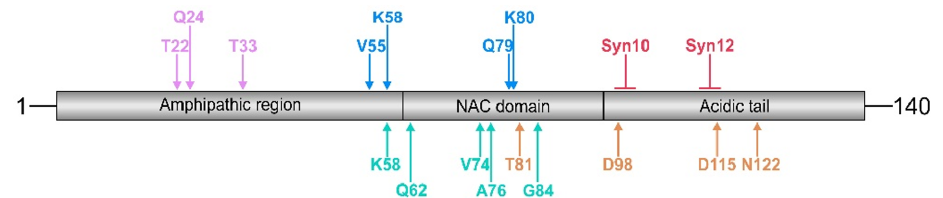
Figure 1. Schematic presentation of cleavage sites within the α -synuclein molecule generated by trypsin (purple), MMP-3 (blue), calpain-1 (green), cathepsin D (red), and neurosin (orange). Cathepsin D induces the formation of 10 kDa and 12 kDa α -synuclein fragments (Syn10 and Syn12, respectively). Note that cleavage sites for a given protease cluster in distinct α -synuclein domains, such as the N-terminus (trypsin), the NAC domain (MMP-3 and calpain-1), and the C-terminus (cathepsin D and neurosin). The numbers above the arrows indicate the position of the free N-terminal amino acid generated. For further details, subcellular localization, and references, see Table